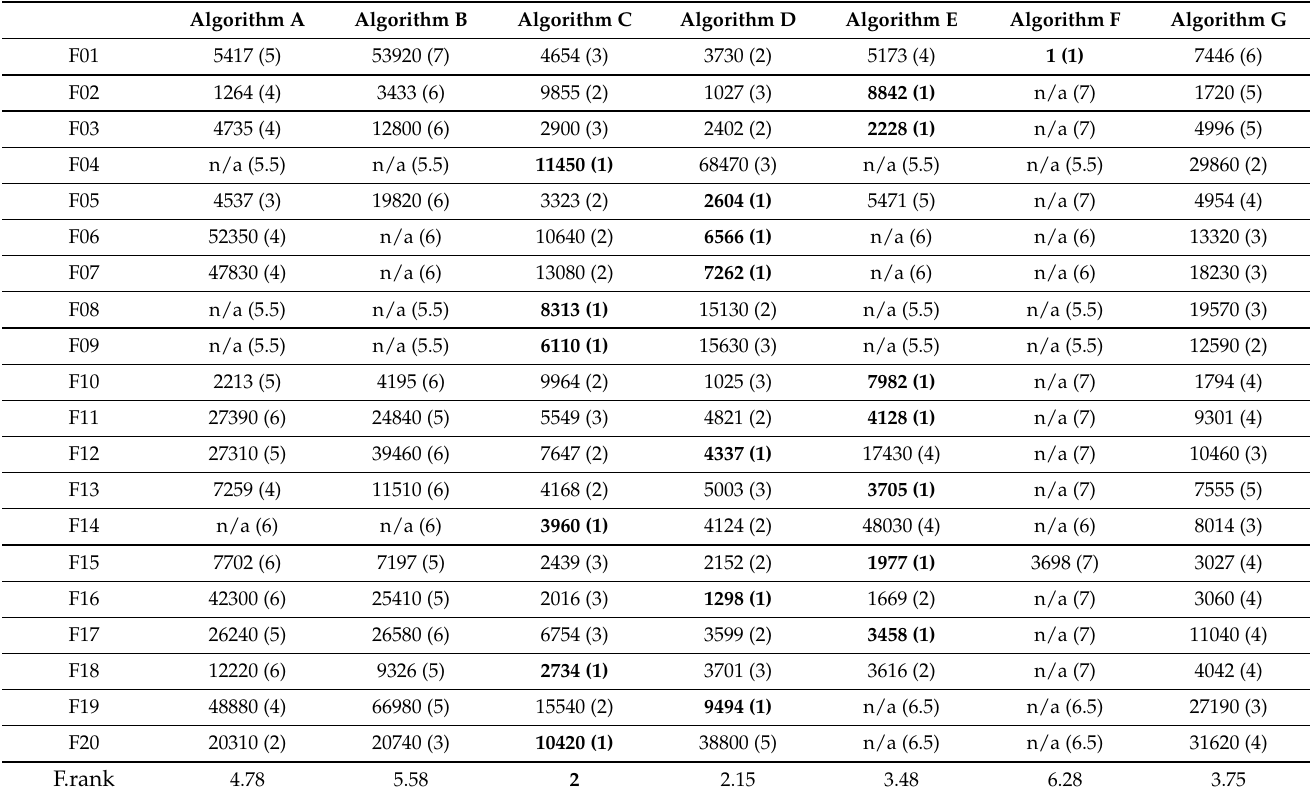
Table 4. Arithmetic mean of the required number of function evaluations with corresponding rank when unsuccessfu cases are simply ignored— the wrong way to report